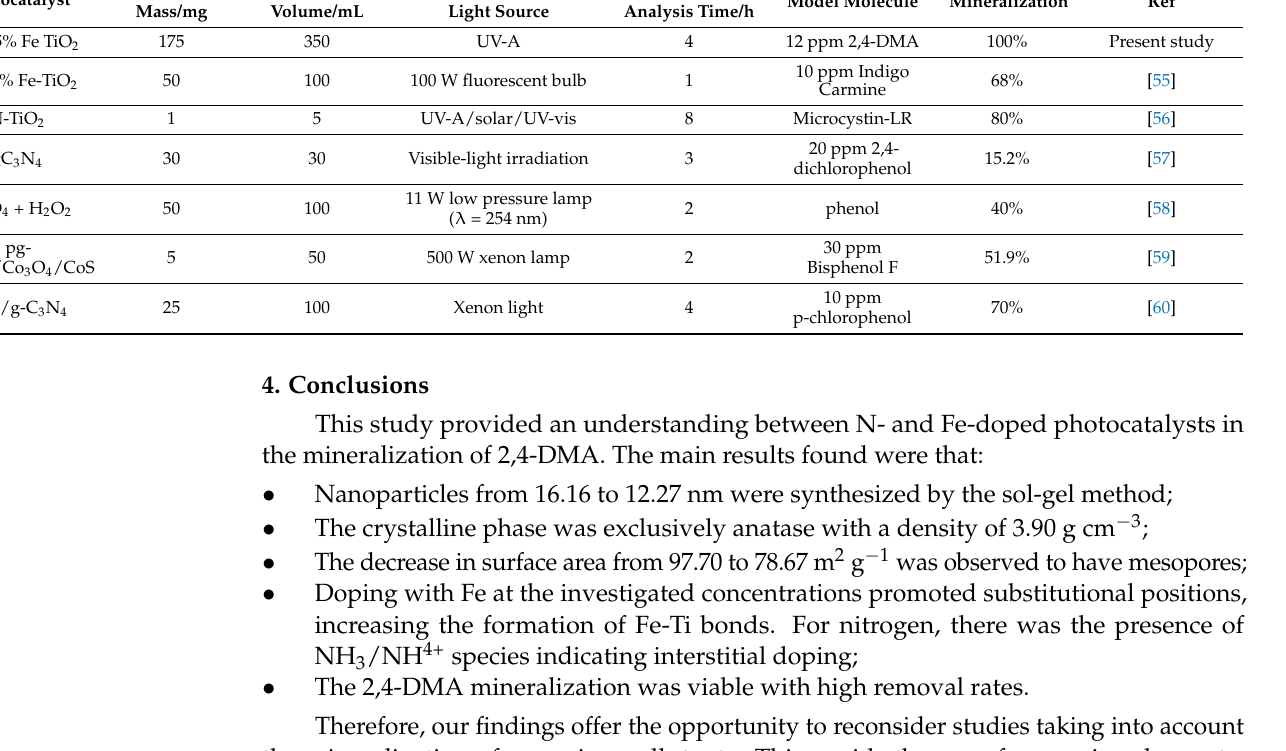
Figure S4: Results for 2,4-DMA mineralization using co-doped photocatalysts fixing 0.025%Fe and varying N doping by 3 and